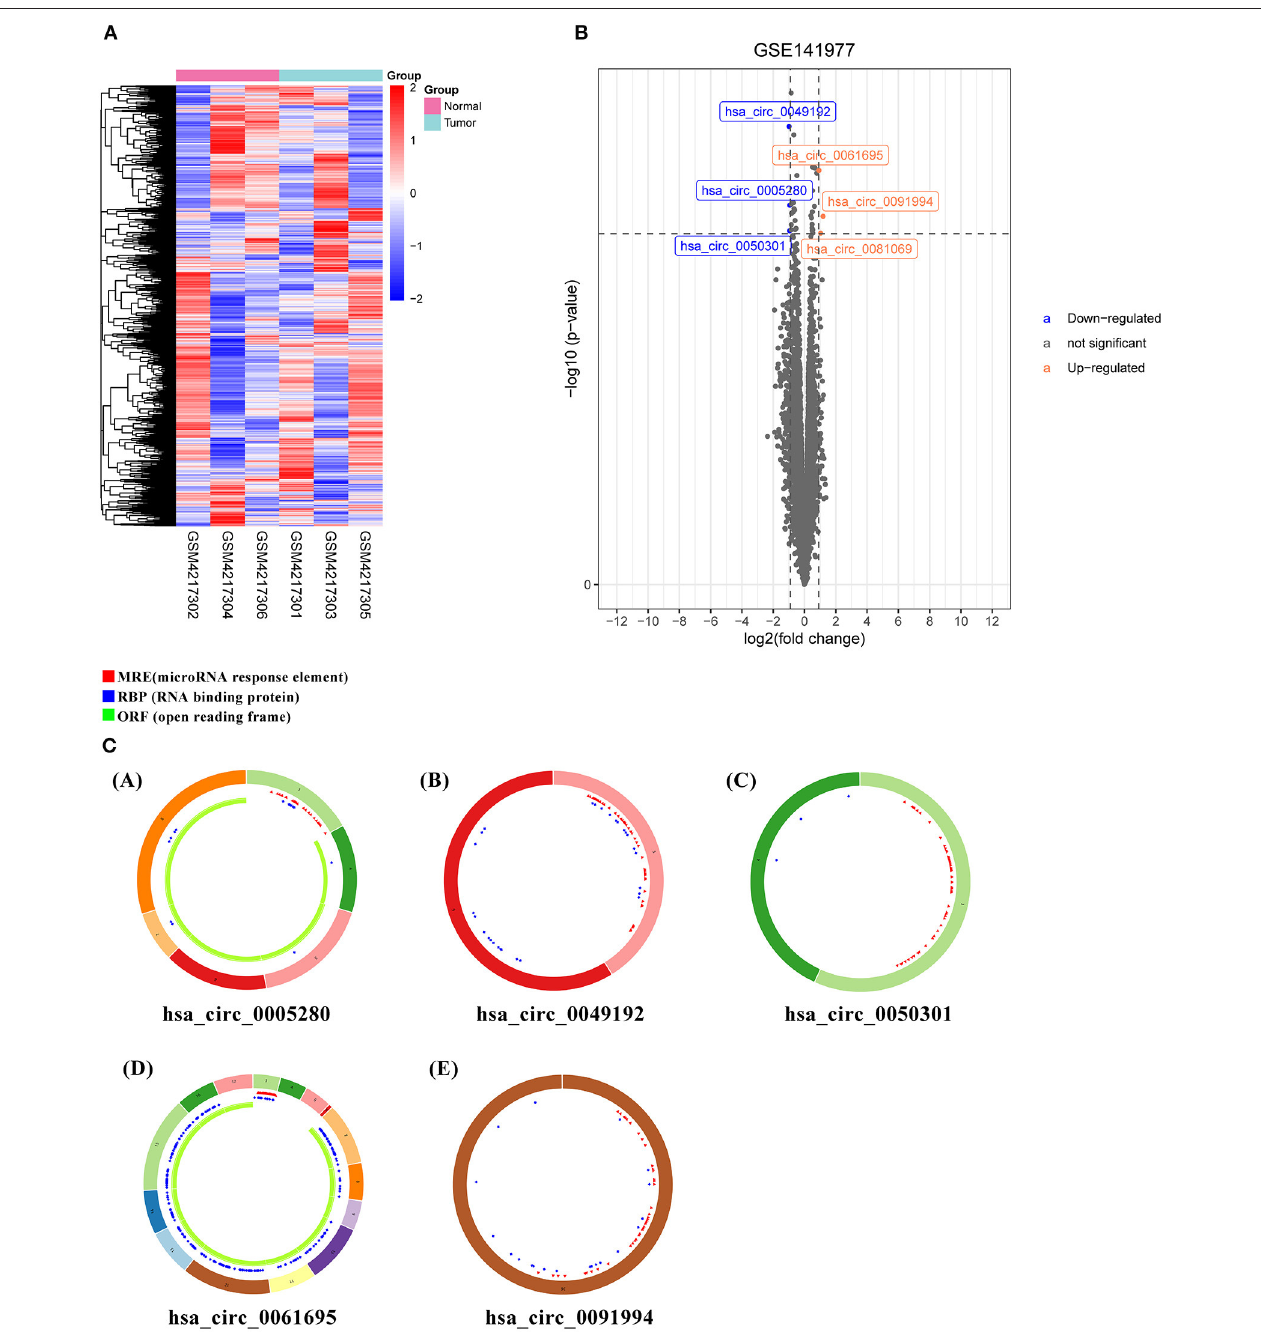
FIGURE 1 | Differently expressed circular RNAs (DECs) and predicted CircRNA structure. (A) Heatmap of top six DECs. (B) Volcano plot of DECs. (C) Predicted CircRNA structure of the top six DECs. Each arc with a numeric ID depicts one exon. The red spots represent microRNA (miRNA) response elements (MRE), the blue spots represent RNA binding protein (RBP), and the green curves represent open reading frame (ORF).